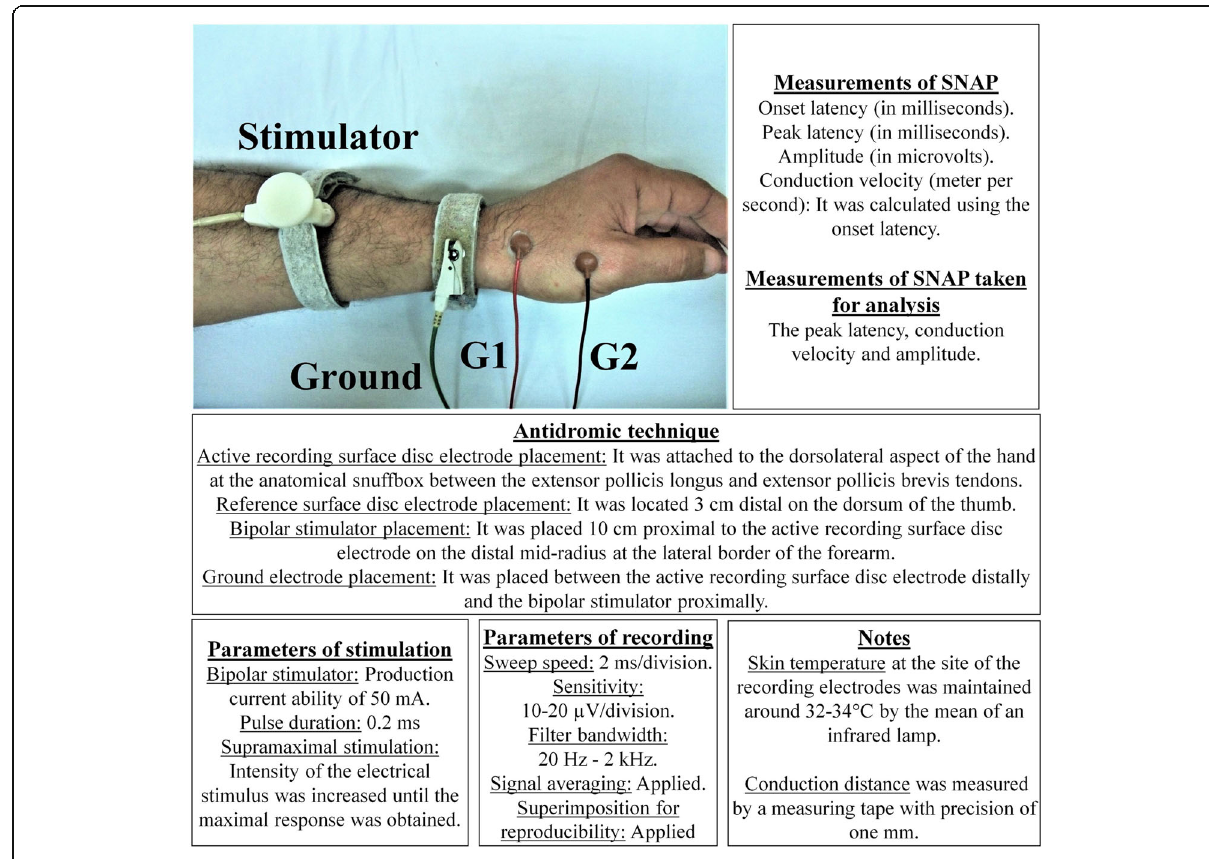
Fig. 4 Illustration of the superficial radial nerve sensory conduction study using an antidromic technique. It shows the stimulation and recording positions [6, 13, 18, 19]. Ground, ground electrode; G1, active recording surface disc electrode; G2, reference surface disc electrode; Stimulator, electrical bipolar stimulator; SNAP, sensory nerve action potential; mA, milliampere; ms, millisecond; μ V, microvolt; Hz, Hertz; kHz,